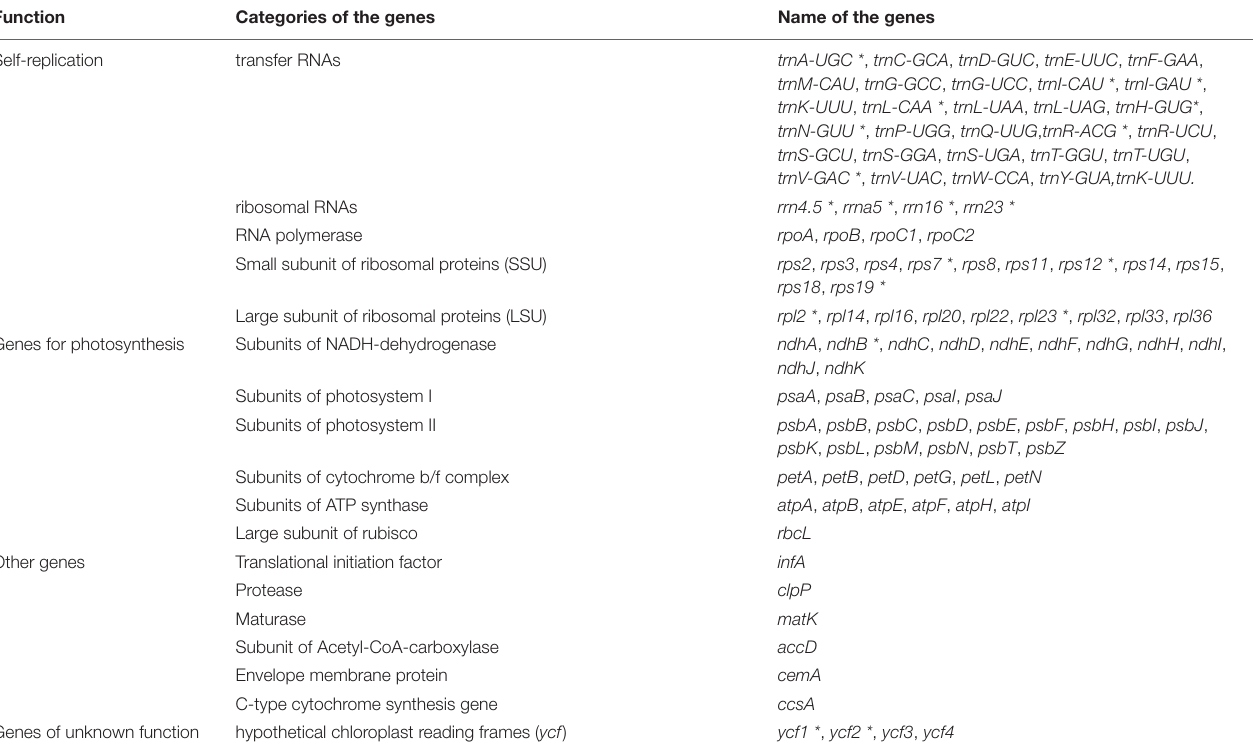
TABLE 3 | Group of genes encoded in the Acanthochlamys bracteata, Xerophyta spekei, and X. viscose .